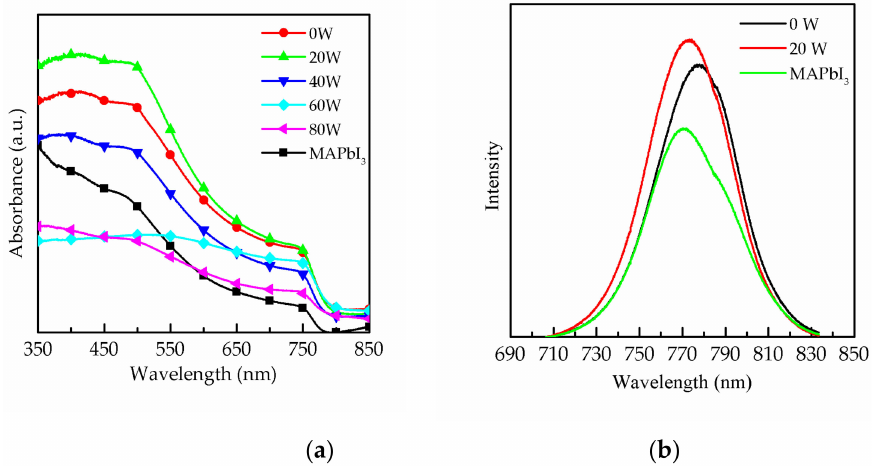
Figure 2. Absorbance spectrum of ( a ) the pure MAPbI 3 film and the MAPbI 3 film with CsPbI 3 QDs treated with oxygen plasma at 0 to 80 W. ( b ) Photoluminescence results of the MAPbI 3 film and composite perovskite films without and with oxygen plasma treatment at 20